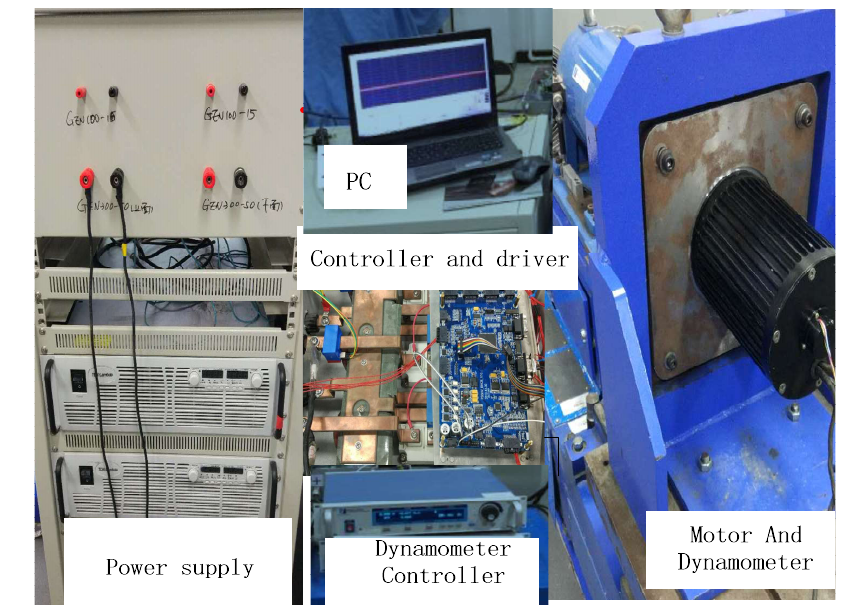
Figure 13. The load test bench of the motor.